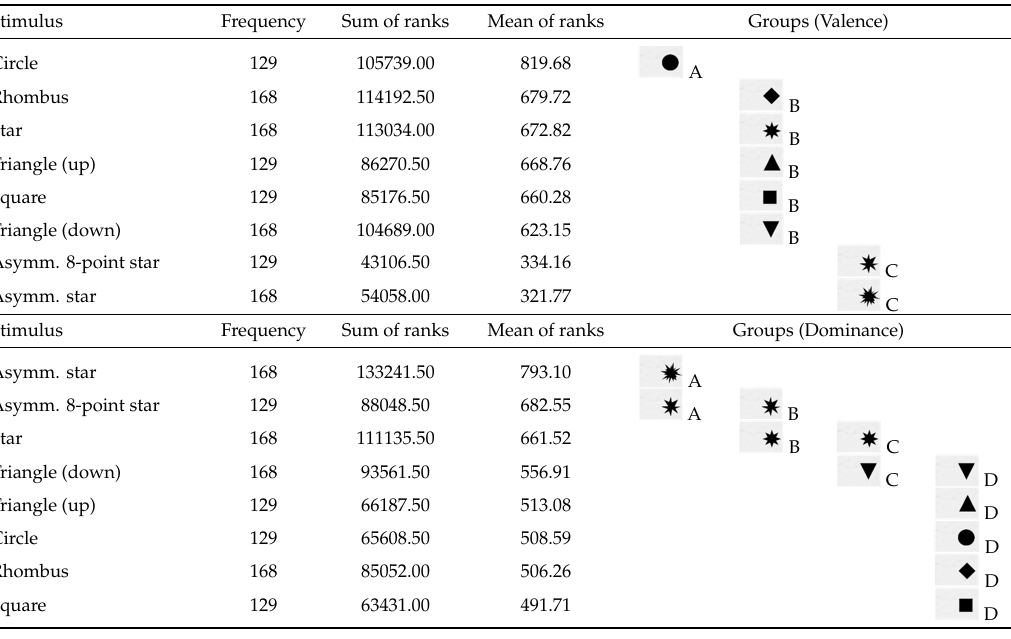
Table 3. Results of multiple pairwise comparisons of map stimulus set 1 indicating groups of similar valence and dominance.